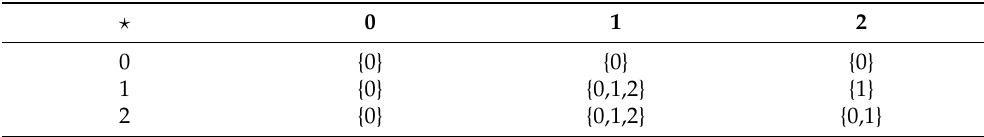
Table 16. The binary hypergroupoid ( C , (cid:63)